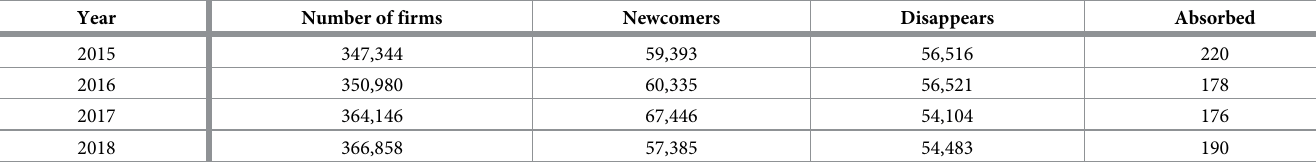
Table 3. Number of firms on the citation networks by type from 2017 to 2018.